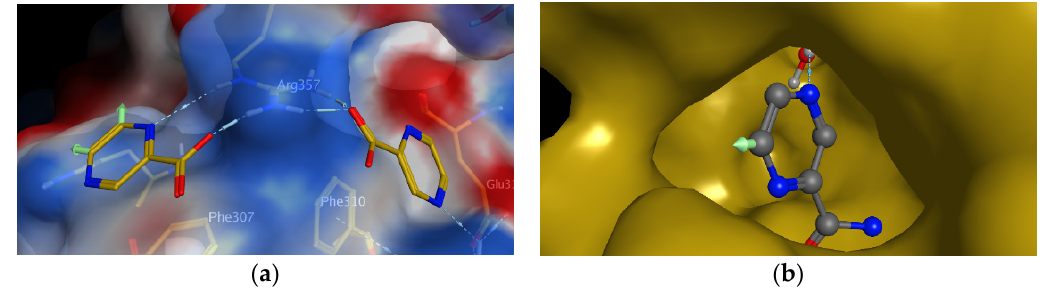
Figure 5. Exit vectors indicated by green arrows designate possible structural modifications of pyrazinamide (PZA) / pyrazinoic acid (POA): ( a ) POA bound to surface of ribosomal protein S1 (pdb: 4NNI) [98]; ( b ) PZA docked into catalytic site of pyrazinamidase PncA (pdb: 3PL1).